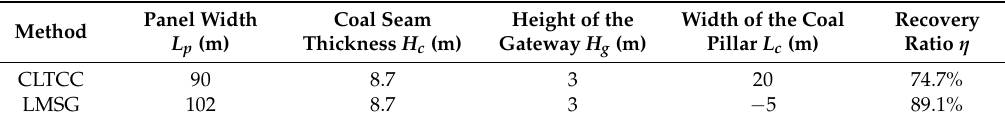
Figure 7. Recovery ratio comparison of the two methods. ( a ) Coal loss in CLTCC and ( b ) coal loss in LMSG. in LMSG. Table 2. Recovery ratio